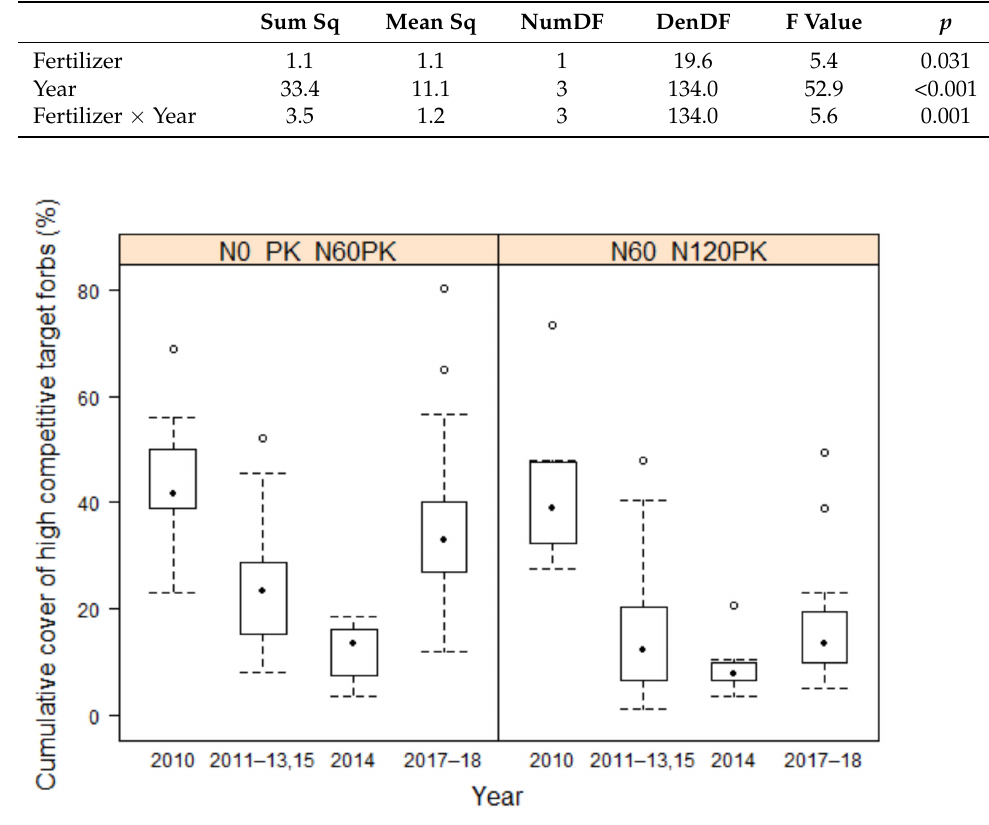
Figure 7. The minimal adequate model for the effect of fertilization treatment and time on the cumulative cover of high-competitive target forbs with different fertilization treatments between 2010 and 2018 (except